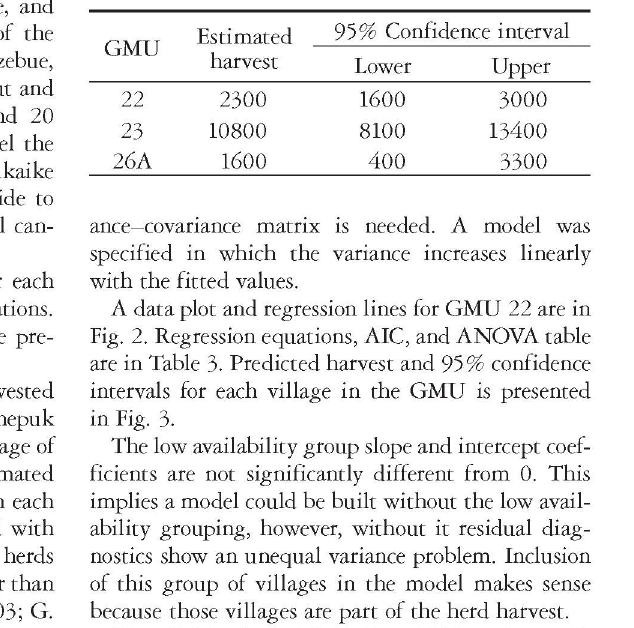
Table 2. Predicted local harvest of Western Arctic Herd caribou by game management unit